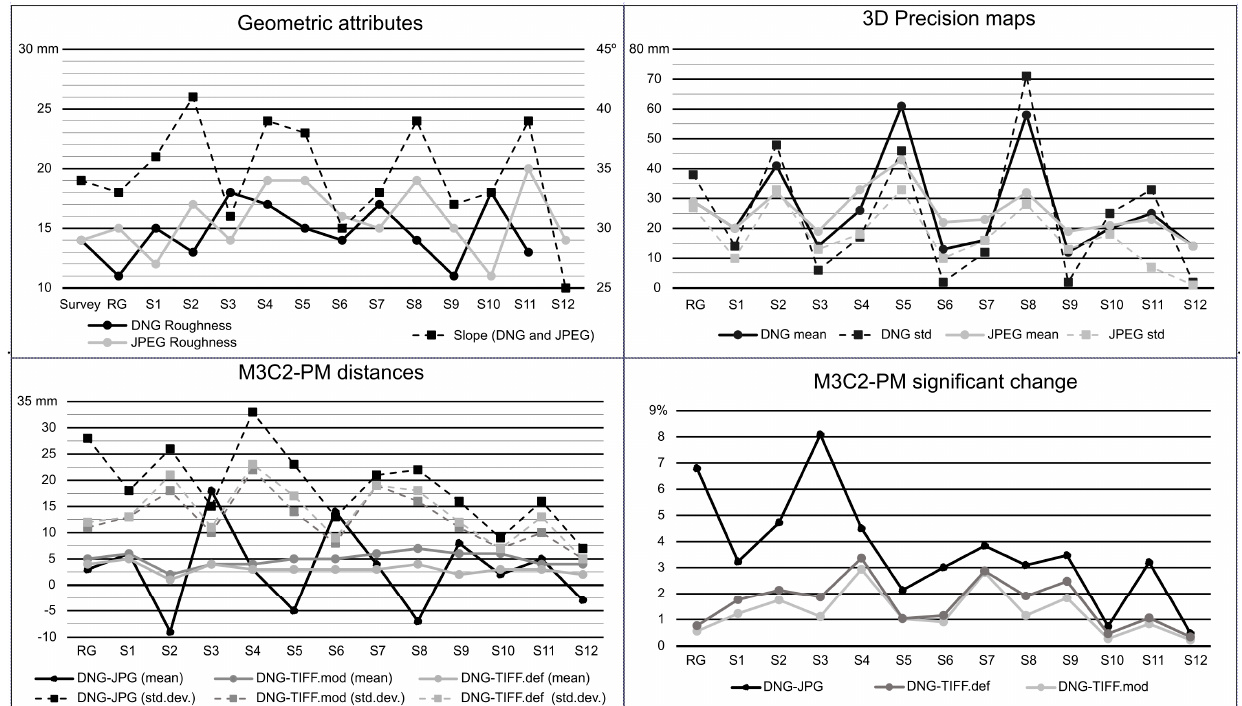
Figure 8. Values of geometric attributes, precisions, and comparisons of SfM surveys in the studied areas.